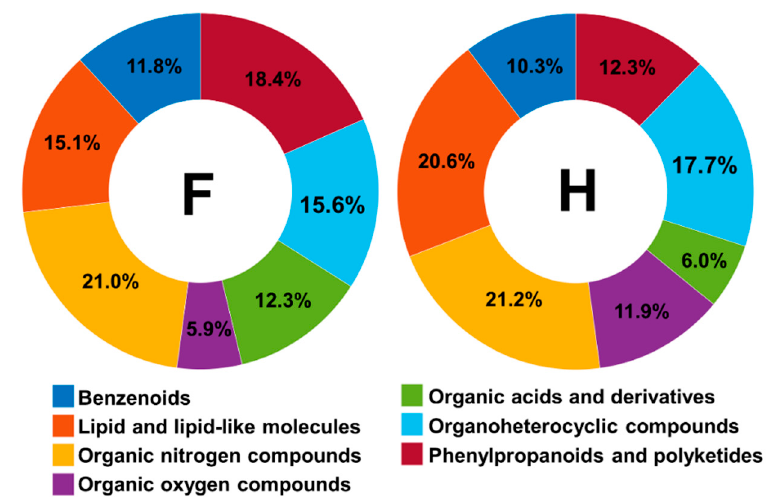
Figure 5. Nodes number detected through MolNetEnhancer at the “superclass” level for the samples of fungal-infected plants (F) and healthy (H) plants.